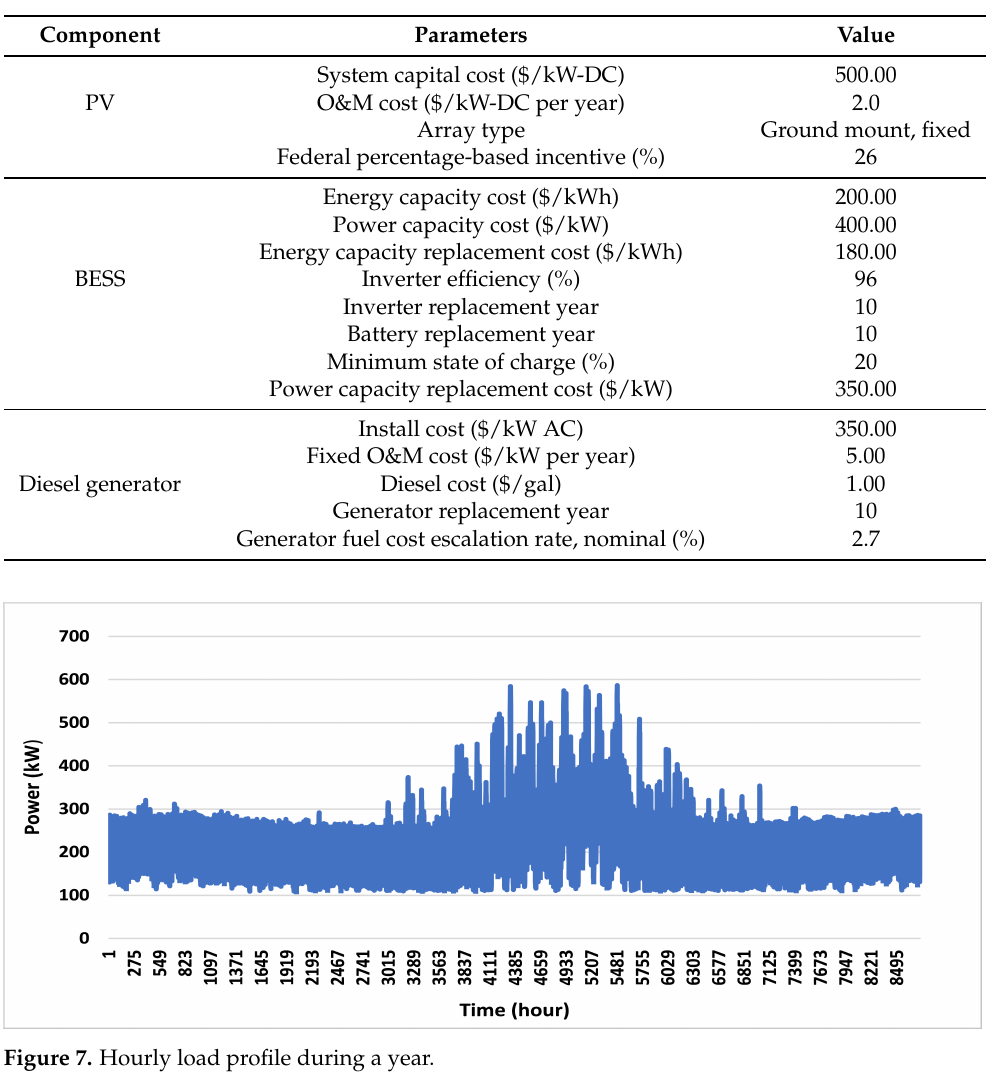
Table 1. Parameters of the microgrid components.